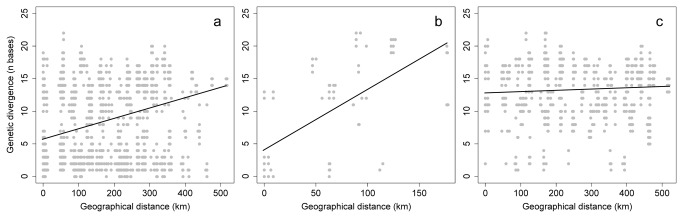
Relationship between genetic and geographic distance for (a) conspecific specimen pairs within 

P

. azureus
, (b) conspecific specimen pairs within 

P

. regius
, and (c) interspecific specimen pairs (

P

. azureus

/P. regius).The straight lines are the fitted linear functions.